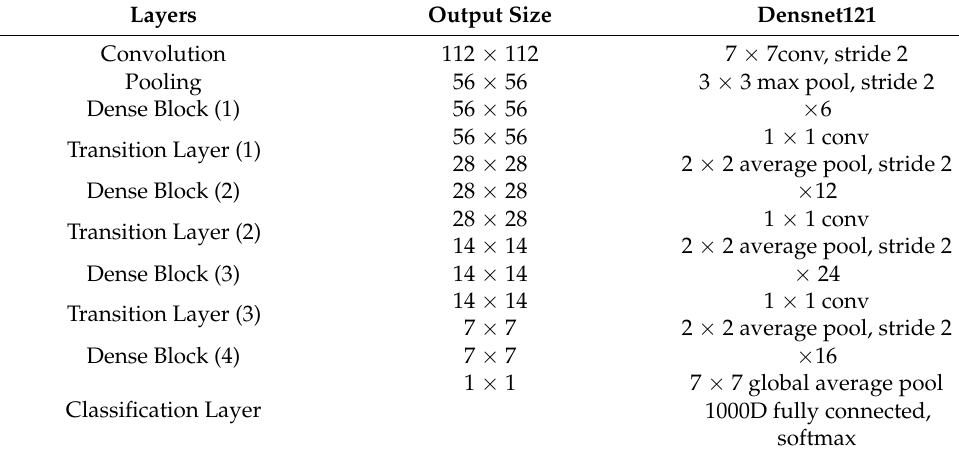
Table 6. Densenet121 construction.